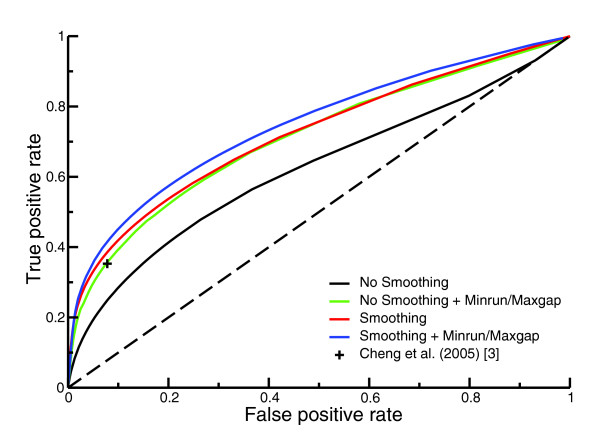
ROC curves showing true positive rate versus false positive rate relative to transcripts annotated in the UCSC database. The '+' symbol corresponds to the transfrags as defined by Cheng et al. [3]. Lines correspond to our algorithm as applied with/without neighborhood smoothing and with/without minrun/maxgap post-processing.